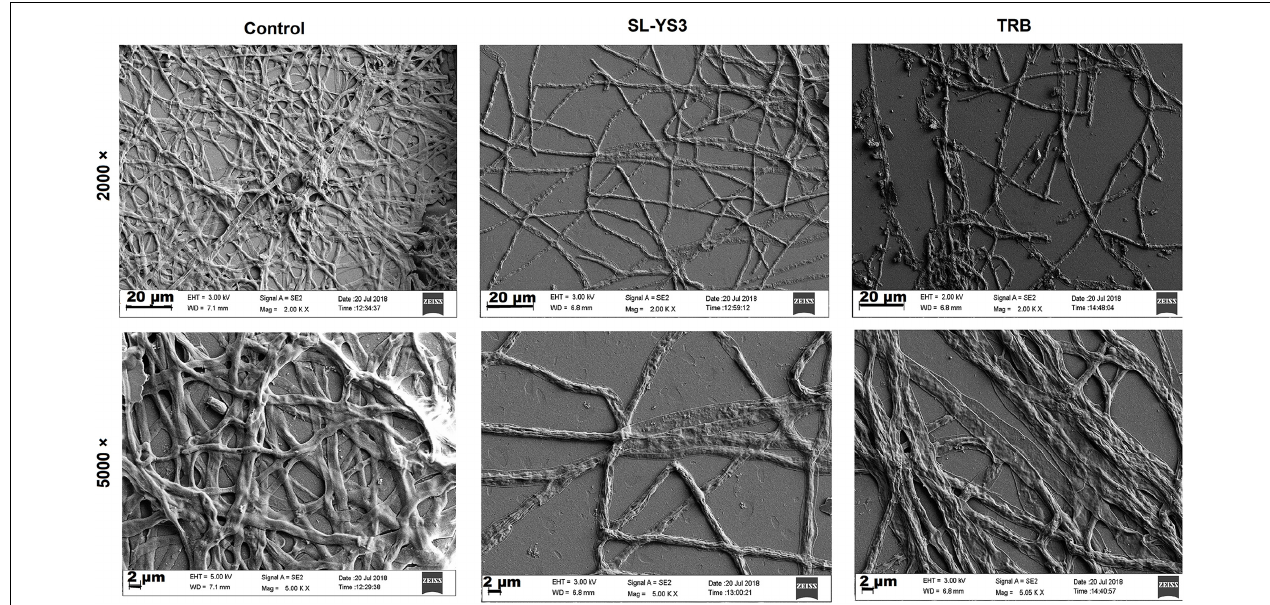
FIGURE 7 | Scanning electron microscopic (SEM) images of the effect of sophorolipid produced by R. babjevae YS3 and terbinafine (TRB) on mature biofilms of T. mentagrophytes . Scale bar = 20 µ m (2000 × ), 2 µ m (5000 × ).